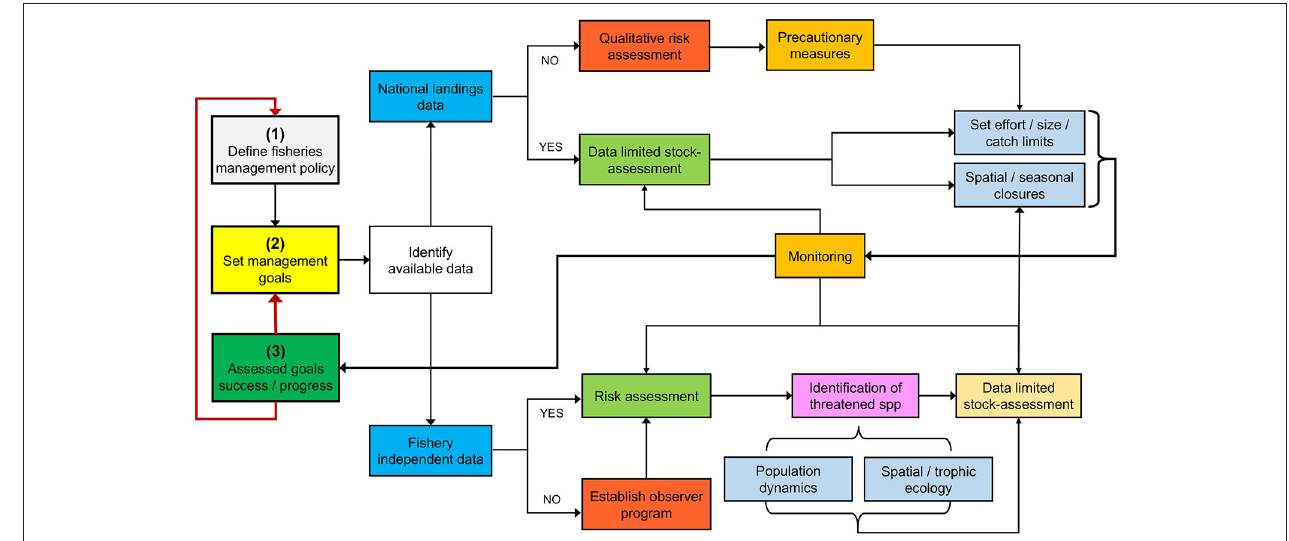
FIGURE 6 | Adaptive management framework for data-deficient fisheries using Costa Rica as a case